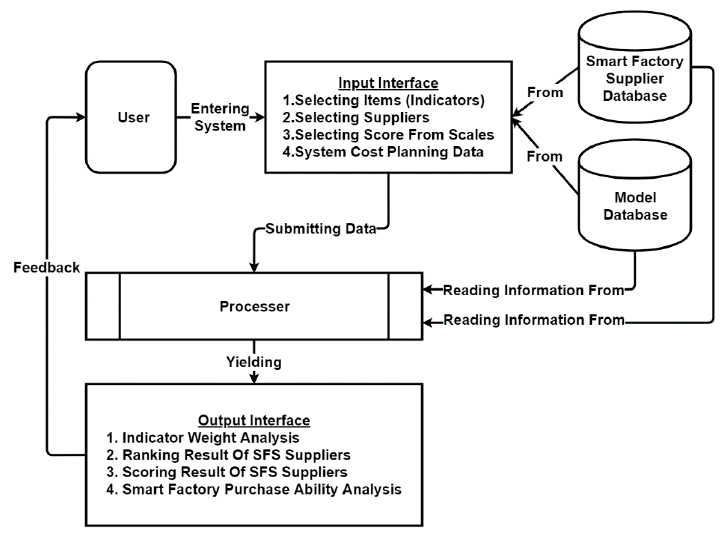
Figure 5. The Framework and prototype of the SFRS.